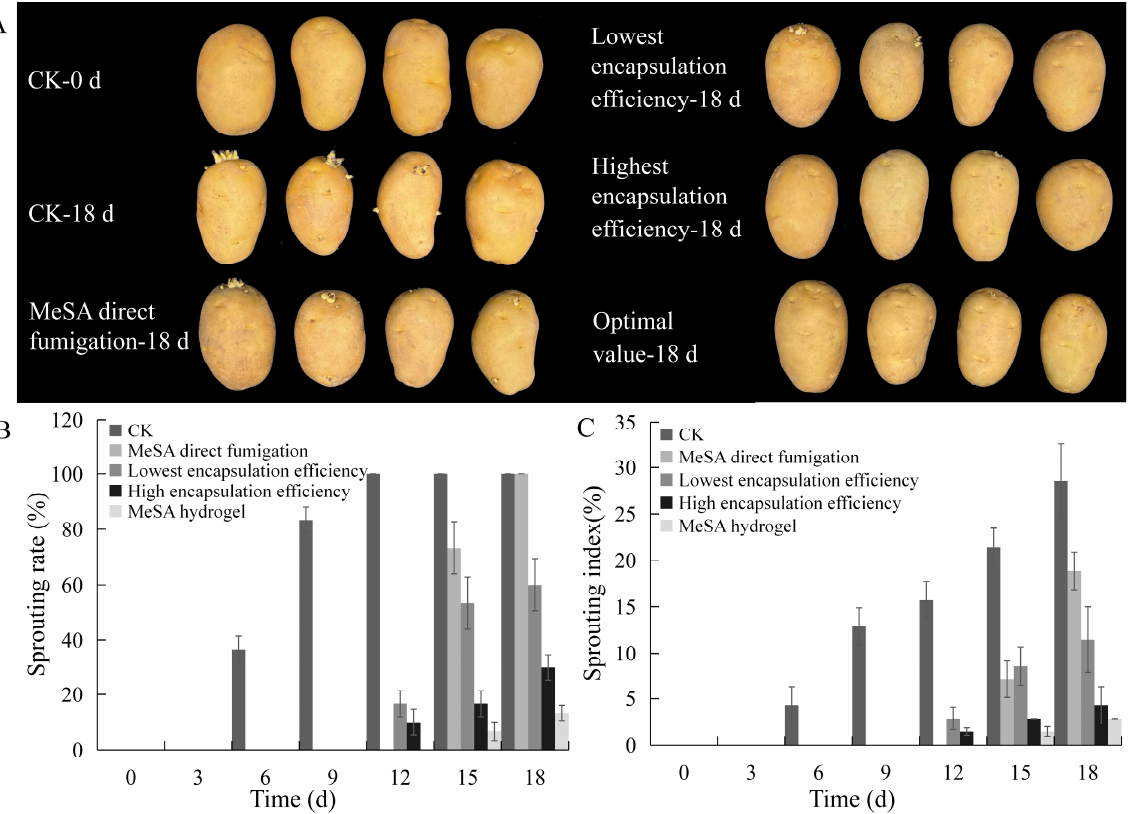
Figure 7. Effect of different treatments on potato tuber sprouting ( A ), sprouting rate ( B ), and sprouting index ( C ). Each value represents mean ± standard deviation of three replicates.